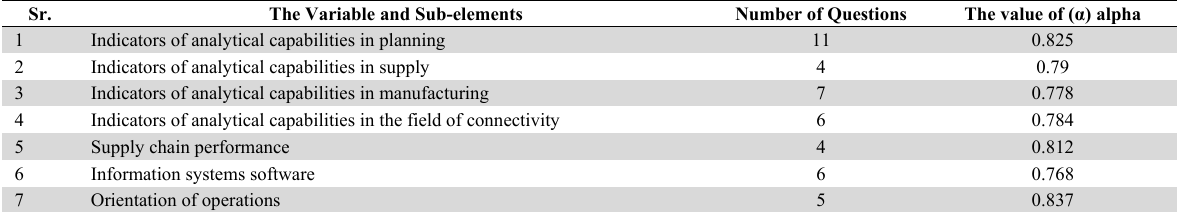
The coefficient of stability of the internal consistency of the dimensions of the resolution (Cronbach Alpha) (n = 357) Sr. The Variable and